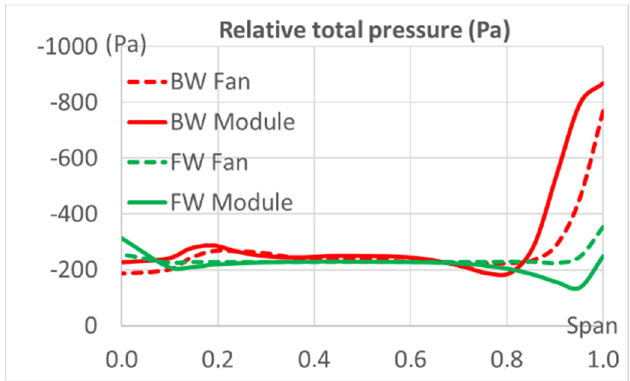
Figure 12. Deficit in relative pressure along the blade span (circumferential averaging 5 mm behind the trailing edge).